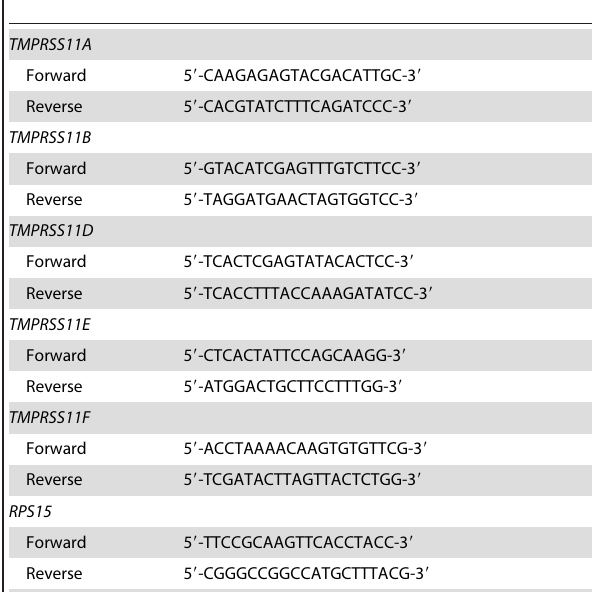
Table 2. Sequences of primers used for expression analysis of HAT/DESC genes in human